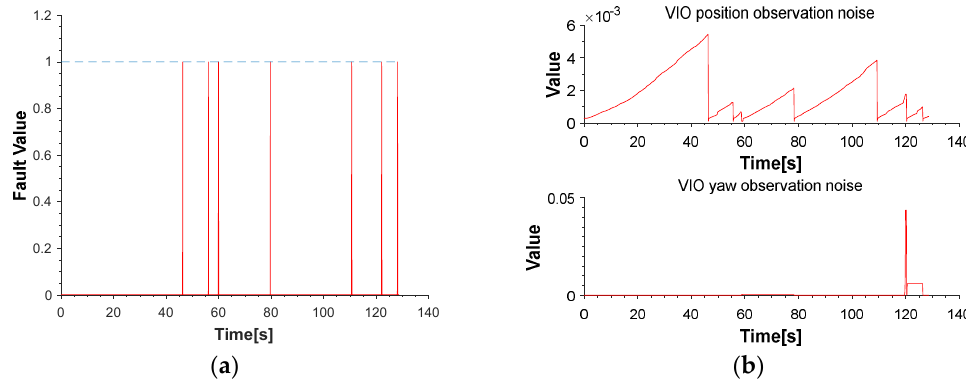
Figure 12. ( a ) The value of fault detect function demonstrates the dramatic change. ( b ) An illustration of the value of position and yaw observation noise.